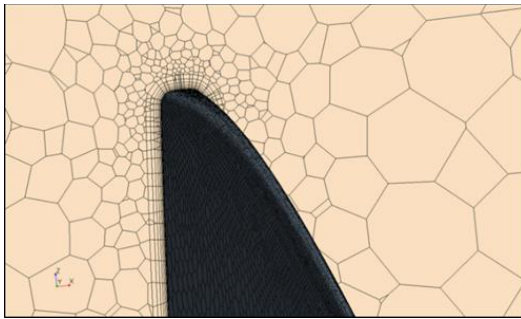
Figure 2. Details of computation mesh around the propeller blade tip.